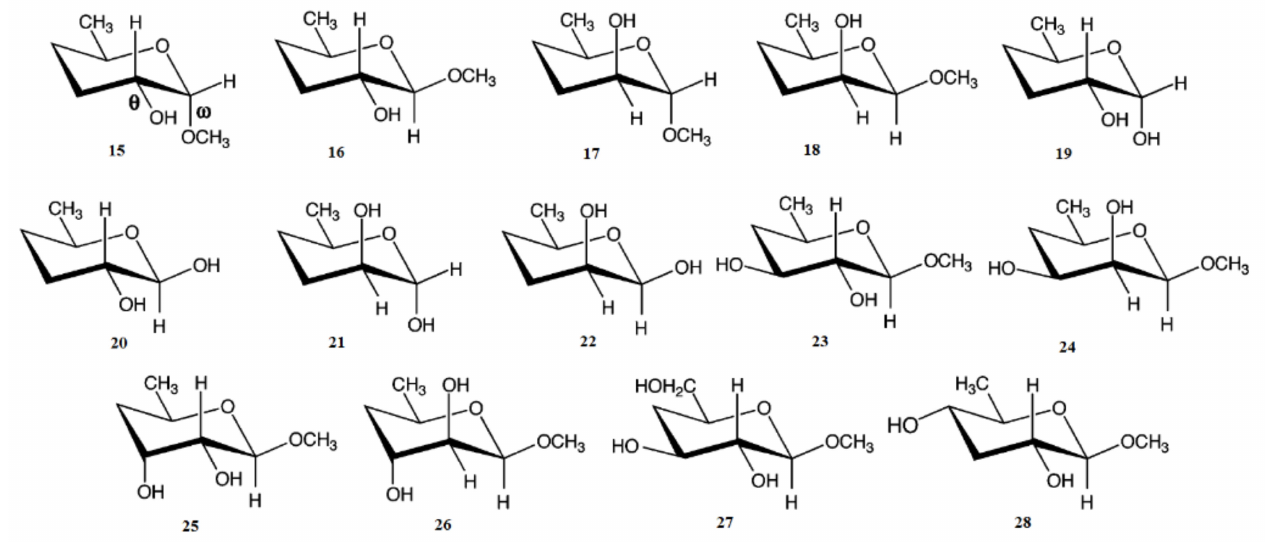
Scheme 3. Model compounds chosen to represent α - and β -D-aldohexopyranoses and methyl α - and β -D-aldohexopyranosides. Reproduced from Zhao et al. [124] with the permission of the American Chemical Society.